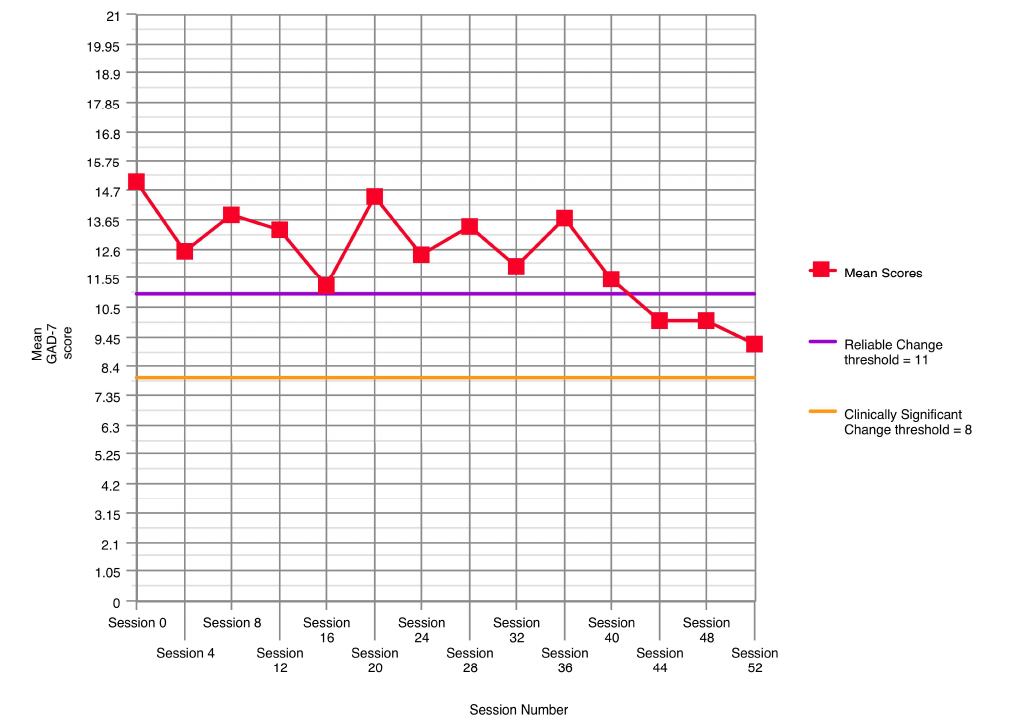
Figure 3: Table 6: Mean GAD-7 score: 8 long-term